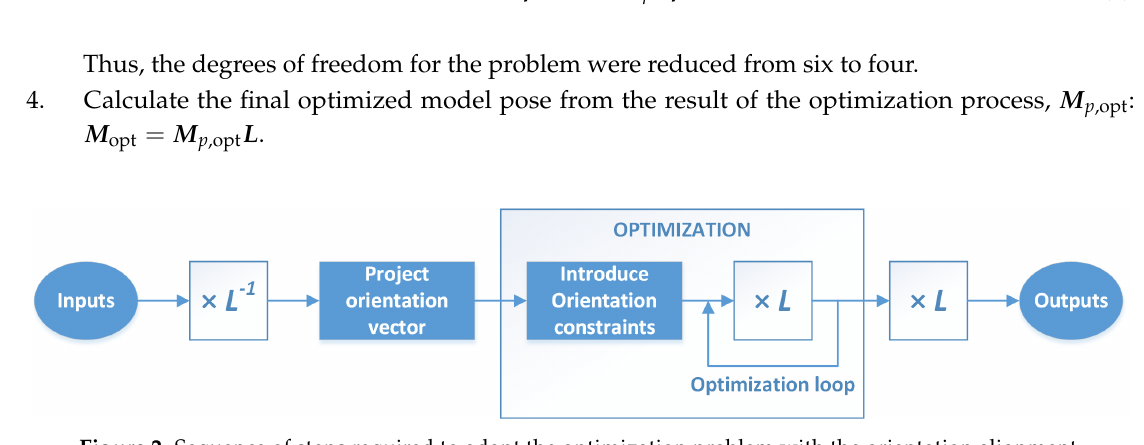
Figure 2. Sequence of steps required to adapt the optimization problem with the orientation alignment. This adaptation is required in both the initial pose estimation and the final pose refinement.